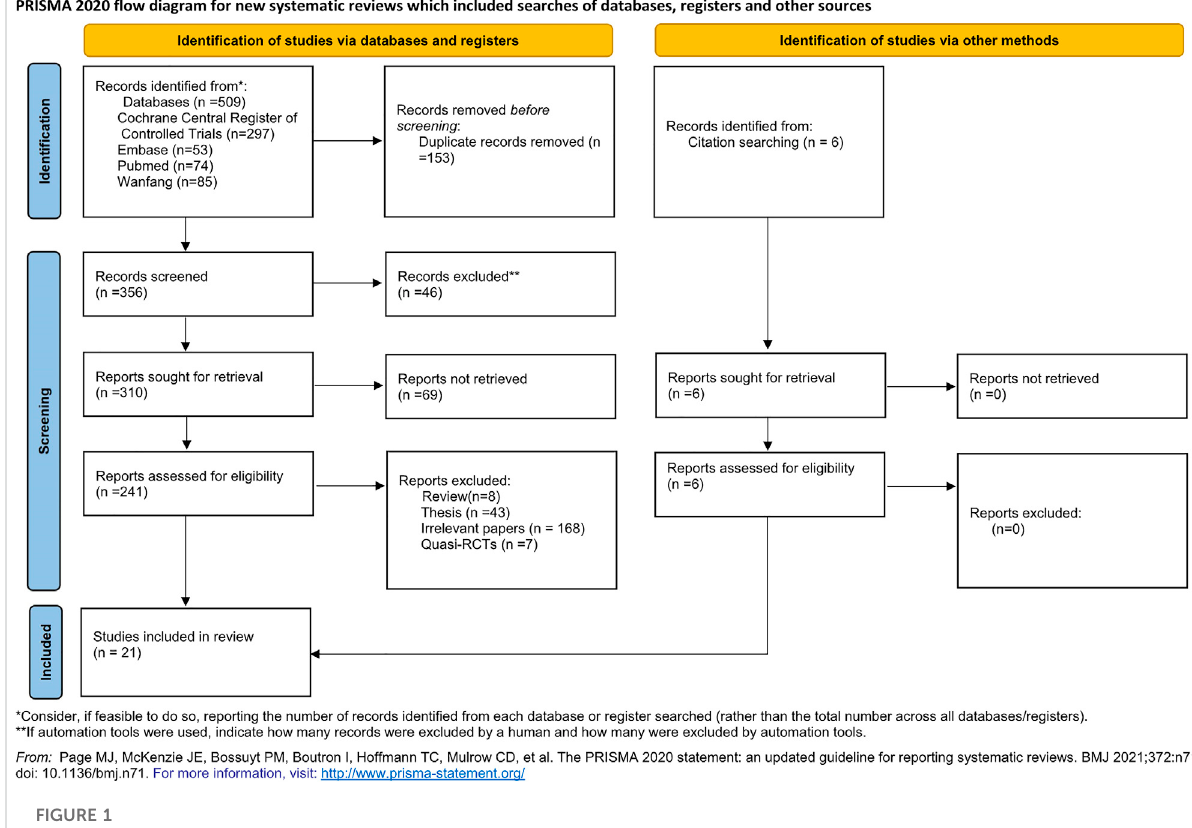
FIGURE 1 Study fl ow